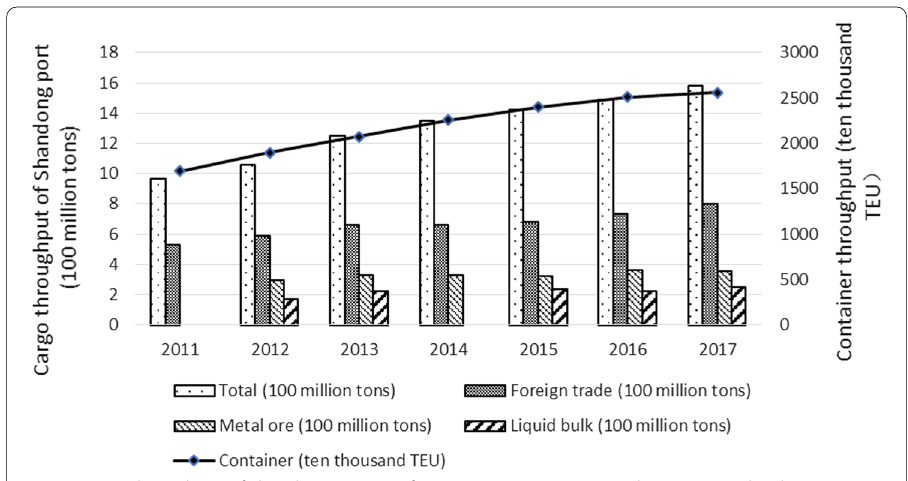
Fig. 5 Cargo throughput of Shandong Province from 2011 to 2017. Source: China port yearbook